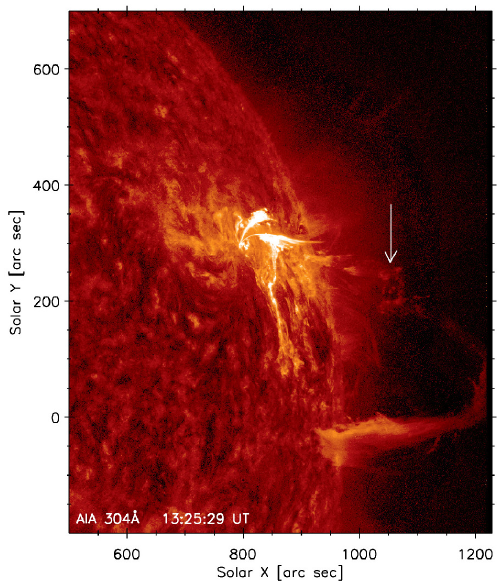
Figure 8. The AIA/SDO 304Å image taken at 13:25:29UT. The arrow shows the unique semi- circular